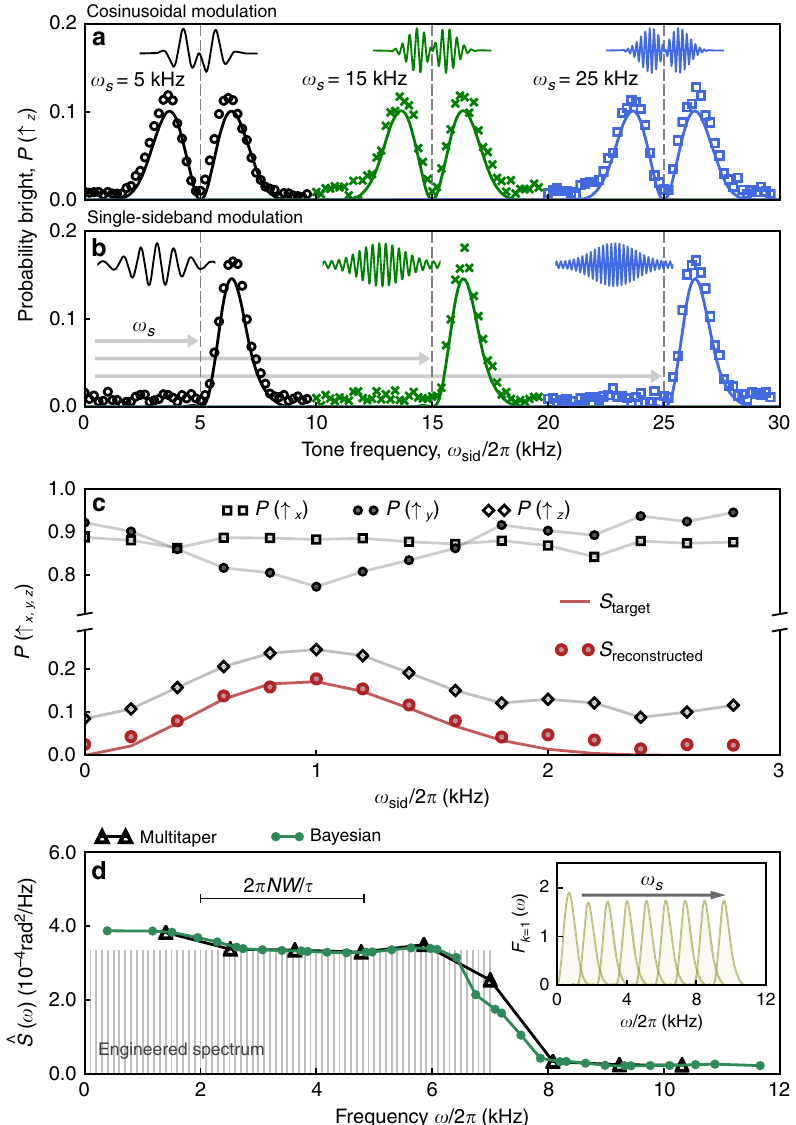
Fig. 3 Sensing techniques and spectrum reconstruction with DPSS-modulated pulses. a Measurements (markers) and expected average fi delity F av (solid lines) for spectral response of band-shifted fi rst-order DPSS fi lter functions with COS modulation. Modulation depth for system identi fi cation measurements was α = 0.5. The pulse shapes are shown as insets for each modulation frequency. b Band-shifted SSB modulated DPSS, using the same (cid:1) (cid:3) modulation frequencies as a . c Protocol for three axes measurements to reconstruct the amplitude fi lter function S target in the presence of white dephasing noise with a root-mean-square amplitude of 5 Ω x , where Ω x is the maximum Rabi frequency of the control. Rotations around the x and y axes allow preparation and readout along all three axes of the Bloch sphere. Projective measurements onto x , y , and z (black markers and lines), expected fi delity under amplitude noise only (red line), and fi delity reconstructed from the three projective measurements (red markers). System identi fi cation measurements were all taken with α = 0.75. d Reconstruction of an applied amplitude noise spectrum (shaded comb teeth) using adaptive and Bayesian multitaper estimation (see text). Inset shows all shifted F Ω ( ω ) for k = 1. Here, ω s ranges from 1.4 to 10.0 kHz in steps of 1.1 kHz. Horizontal scale bar indicates target bandwidth of each